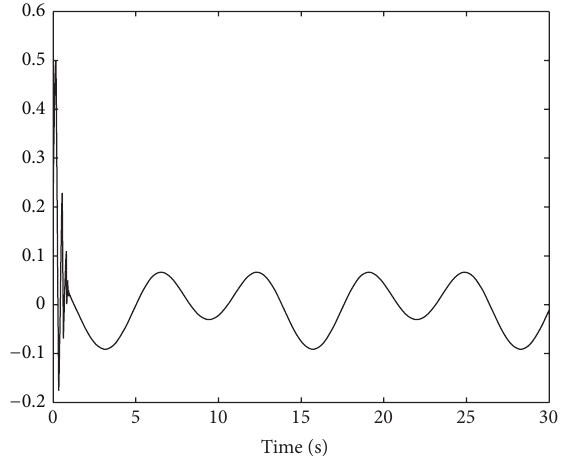
Figure 10: The curve of adaptive parameters